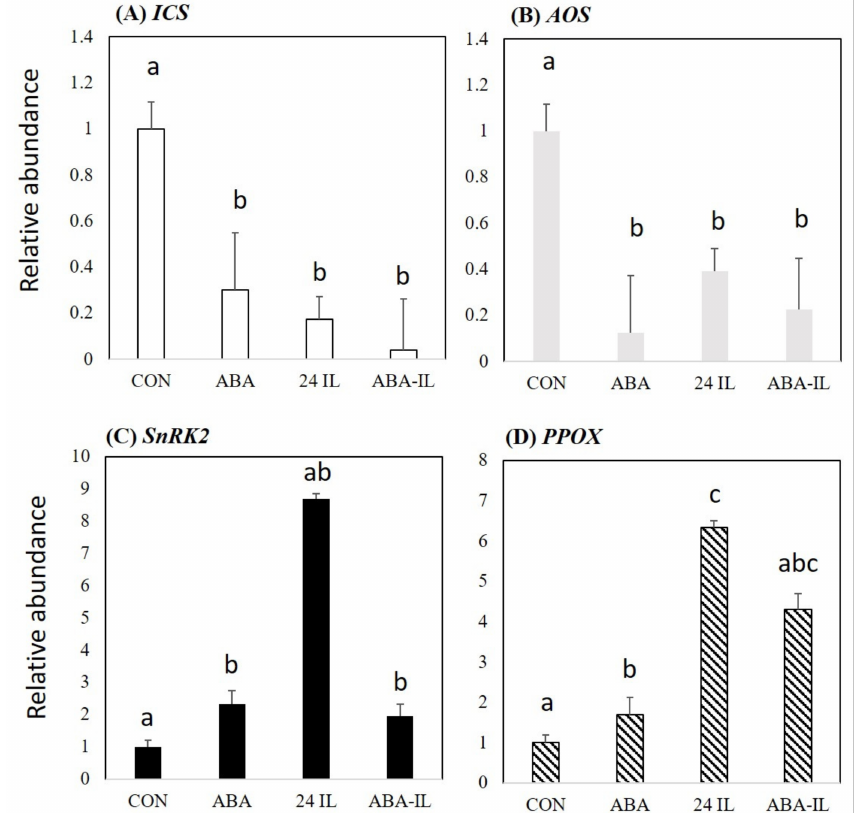
Figure 6. RT-qPCR assessment of ABA effects on key pathways suggested by metabolomic assess- ments of Black Pepper ( Piper nigrum L.) leaves challenged with Phytophthora capsici . Expression